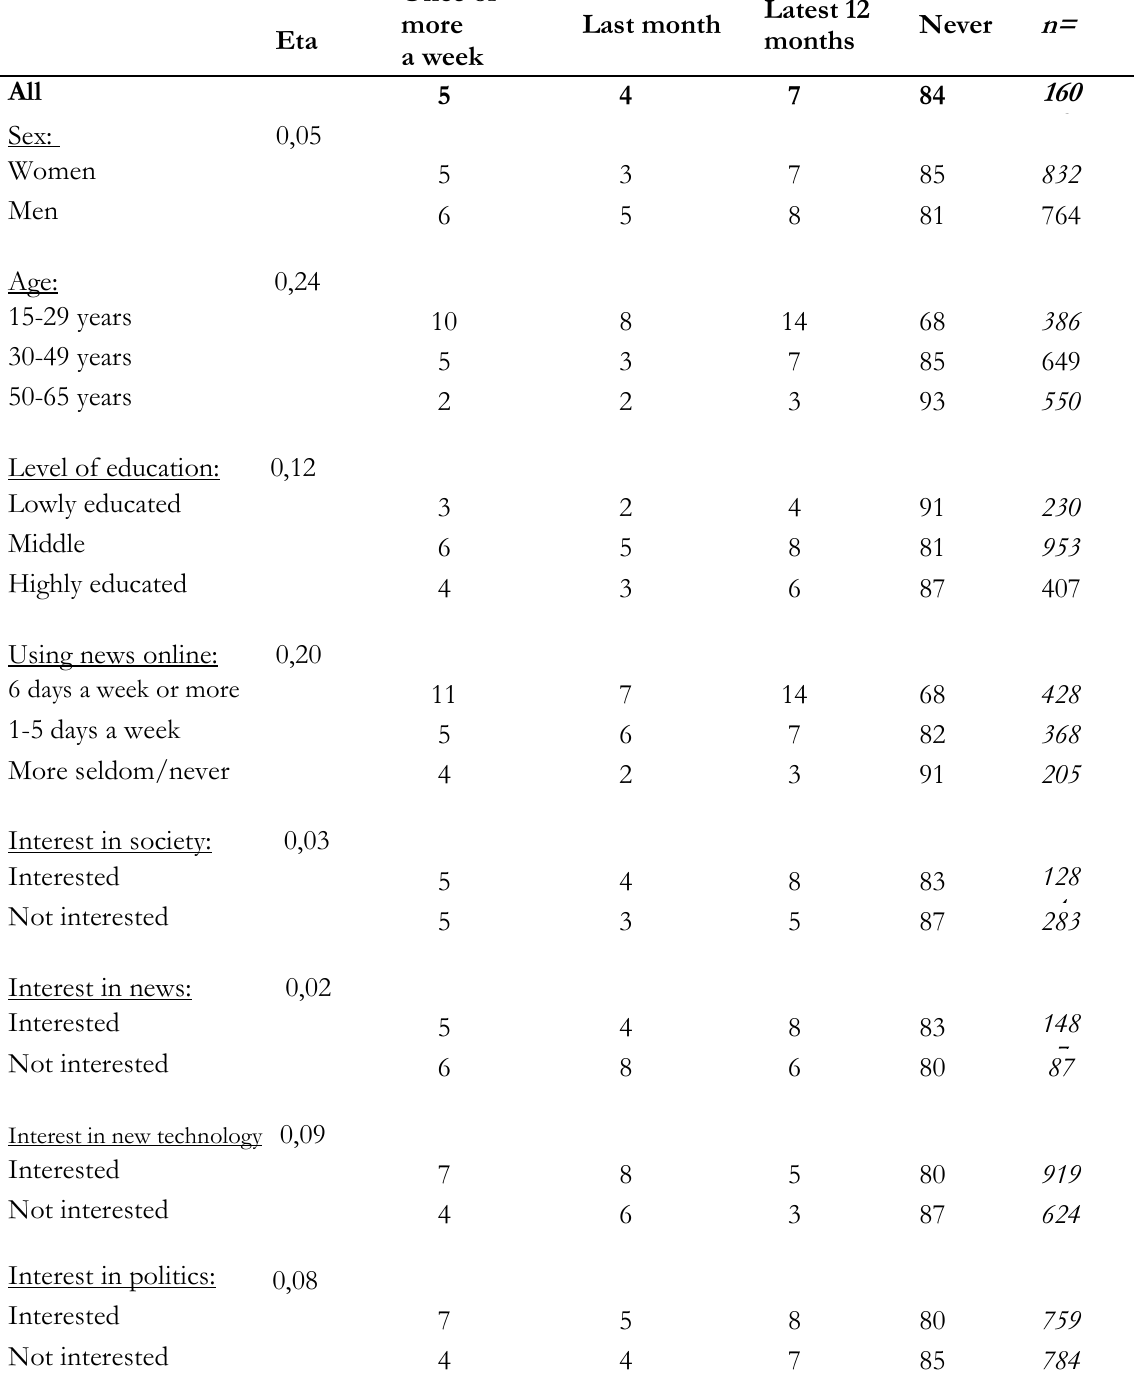
Table 3: Commenting on news sites in different groups (eta and per cent)